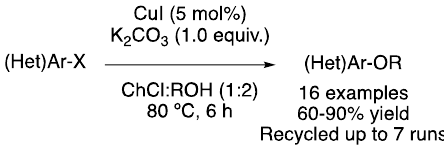
Figure 28. C-O cross-coupling reaction.